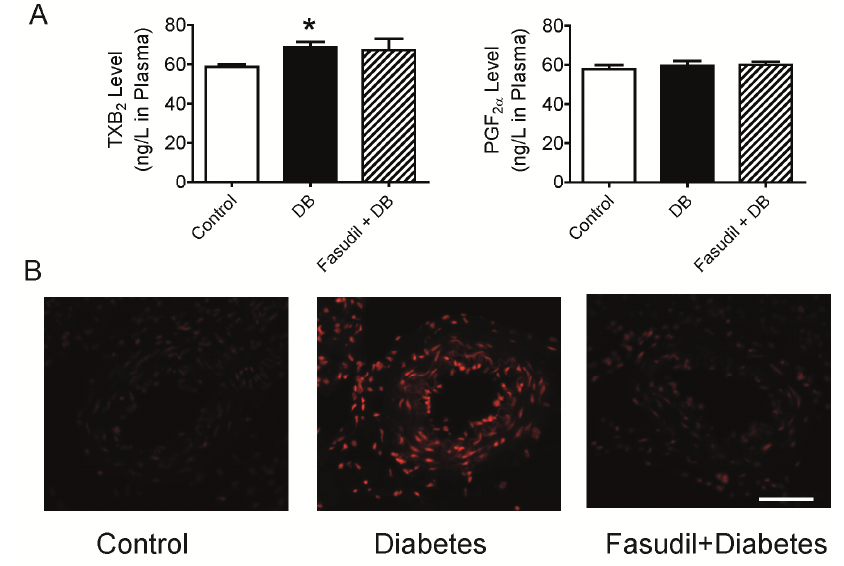
Figure 3. Effects of Rho kinase inhibition on oxidative stress in intrarenal artery and EDCFs in plasma from diabetic rats. ( A ) The concentrations of TxB of rats after 4-week treatment with fasudil. ( B ) Fluorescent photomicrographs at identical settings of sections of intrarenal artery labeled with dihydroethidium and quantification of the fluorescent ethidium signal in the artery by average intensity. Scale bar is 50 μ m shown in the picture. * p < 0.05, *** p < 0.001 compared with control group; ## p < 0.01 when compared diabetic rats with and without treatment of fasudil. Data are mean ± S.E.M. from four–six different